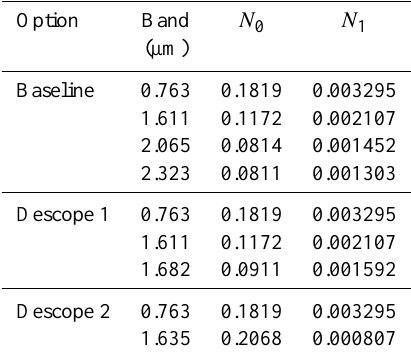
Table 2. Noise parameters for the geoCARB bands. The units of N 0 and N 1 are nW(cm 2 srcm − 1 ) − 1